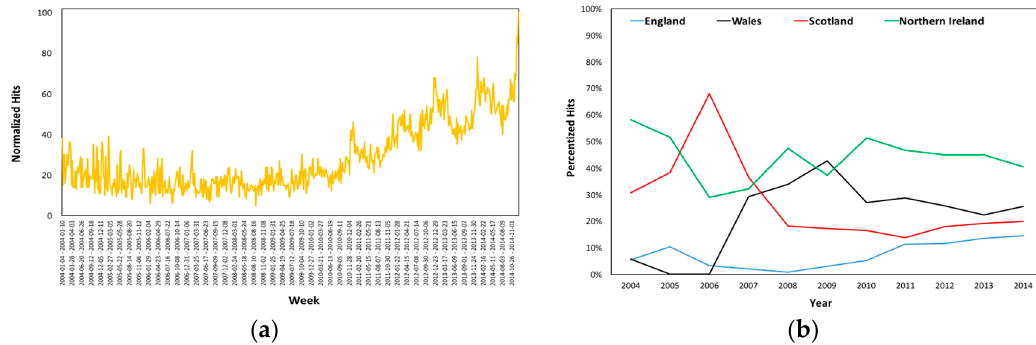
Figure 6. Clarithromycin’s ( a ) Normalized Hits in the UK & ( b ) Regional Percentized Hits Averages 2004–2014.